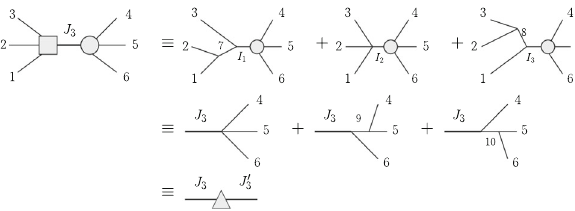
Fig. 2 An example of BG recursion in MG5aMC. Each of the square and circular blobs represent three possible diagrams. The current J 3 is created by combining the three off-shell currents I 1 , I 2 , and I 3 into a single off-shell current (first line), which is then used in three graphs (second line). In this way, 9 Feynman diagrams becomes 3 graphs. A future optimisation would be to also combine particles 4, 5, and 6 into another three-particle current J (cid:3) , which would then have its propagator 3 amputated and be contracted with J 3 (third line)